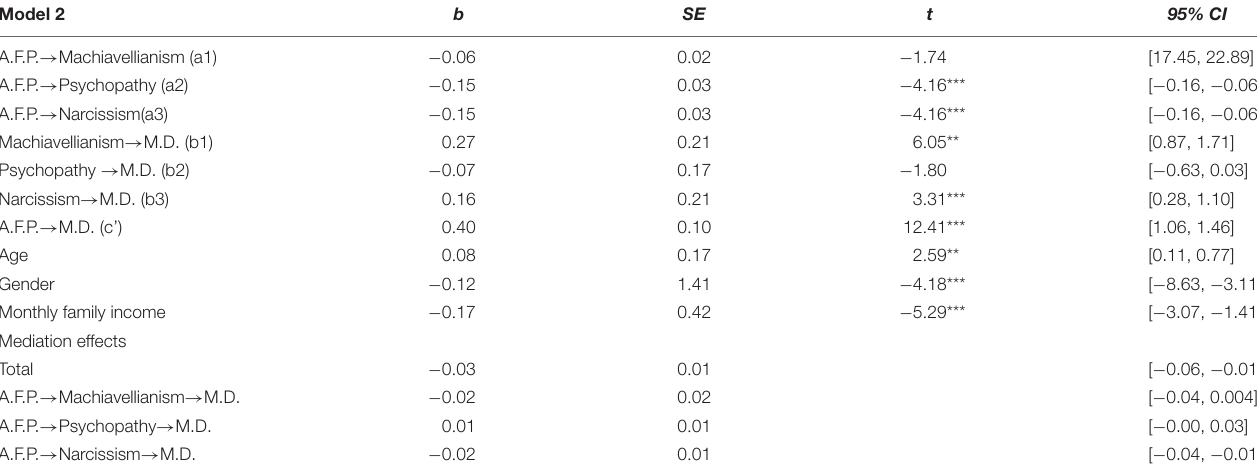
TABLE 3 | Mediation models of authoritarian filial beliefs ( N = 778). Model 2